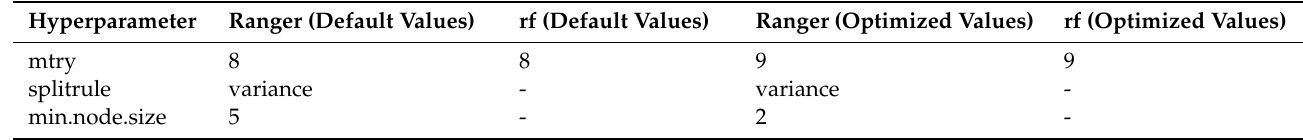
Table 7. The specific hyperparameters of random forests.